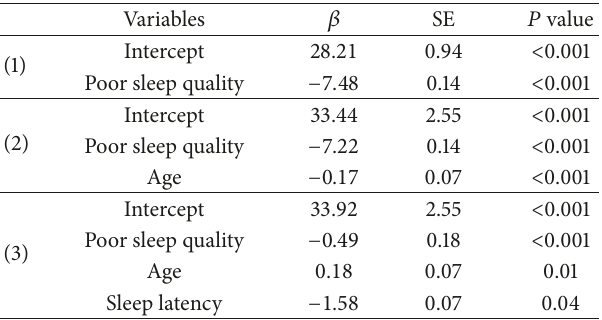
Table 5: The multiple linear regression analysis for assess relation of sexual function with some